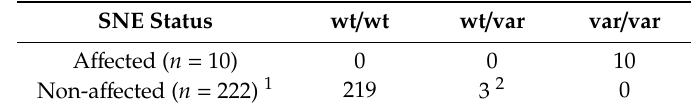
Table 2. Segregation of the SLC19A3 : c.205_210delins35 genotypes with subacute necrotizing encephalopathy in Yorkshire terriers.